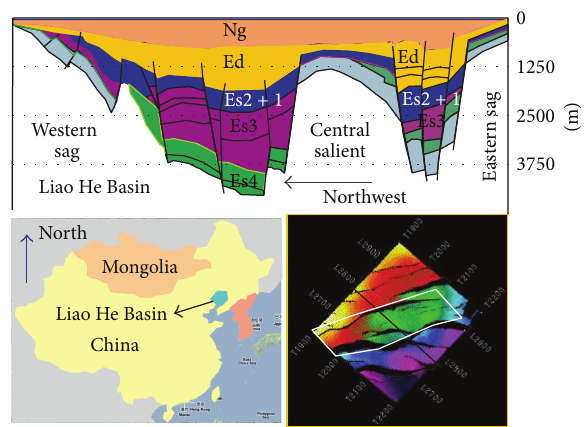
Figure 1: Location map showing the area of study. White circle is the study area; black line is seismic profile in Figure 2.